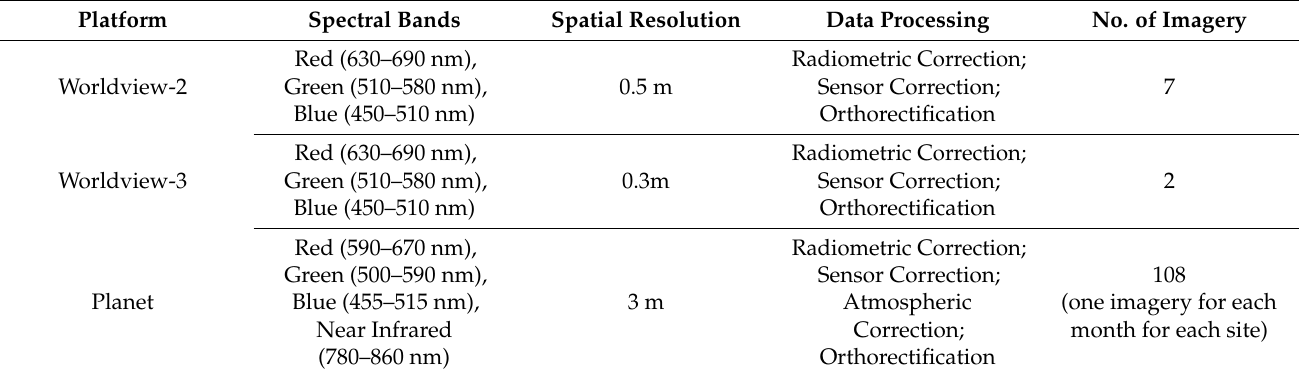
Table 2. Remote sensing imagery